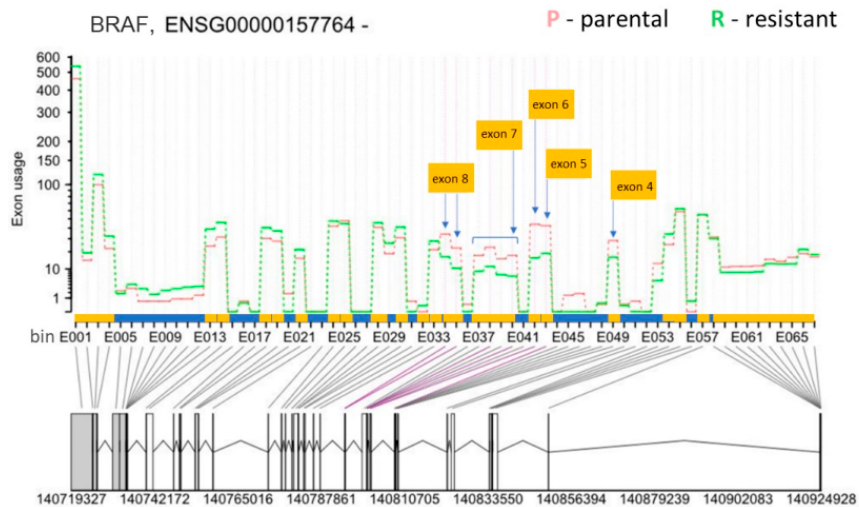
Figure 4. Differential exon usage result for BRAF (Ensembl gene ID: ENSG000000157764) from DEXSeq. The y -axis shows the exon usage (normalised counts corrected for gene expression) in parental (P) and resistant (R) cells for each exon bin annotated for the plus strand ( x -axis). Exon bins (E001, . . . ) are sections of the genome that correspond to whole exons or exon fragments in the gene model, as indicated by the grey lines. X-axis is also demarcated for the gene model with exons (yellow boxes) and introns (blue boxes), with exon one starting at the bin number E068 and exon 20 ending at the bin number E001. Below the x -axis the gene model is shown with numbers indicating genomic coordinates. Boxes represent exons. Horizontal lines represent introns. The vertical or diagonal lines indicate the position of the exon bins in the gene model. Purple lines indicate statistically significant bin usage. The positions of the skipped exons 4 to 7 in the resistant cells are indicated by yellow boxes and the arrows. Table 1. BRAF differential exon usage results from ASpli and DEXSeq.